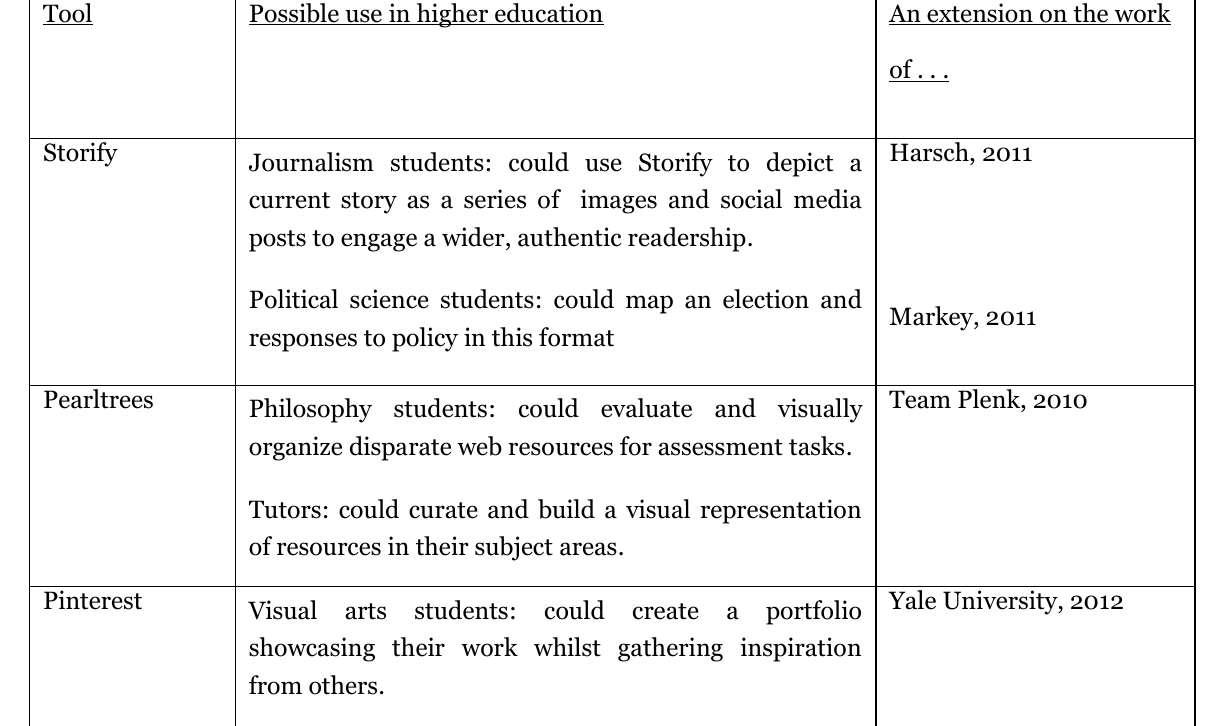
Applications of Digital Curation Tools in Higher Education (Antonio et al., 2012) Tool Possible use in higher education An extension on the work